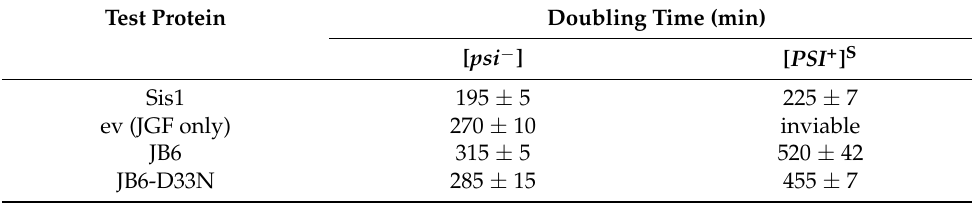
Table 2. Growth rates of FOA-resistant strains. Test Protein Doubling Time